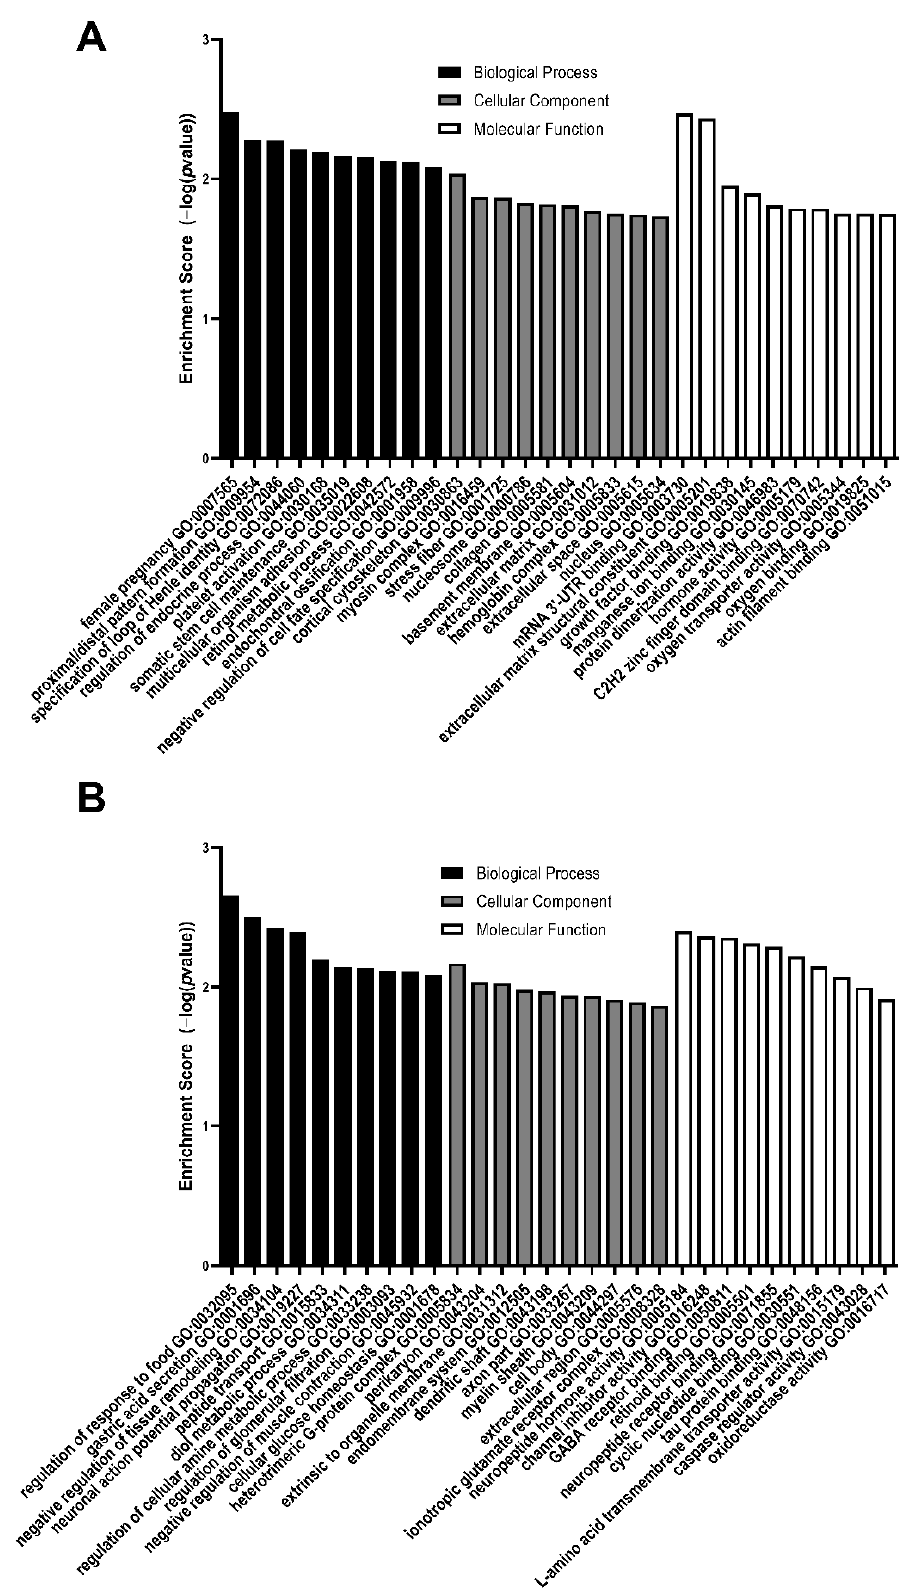
Figure 7. Enrichment scores of the top 10 GO biological processes, cellular components, and molecular function enriched from differentially expressed genes that are ( A ) upregulated or ( B ) downregulated in MMC spinal cords compared to vehicle at E17. All GO pathways were >1.5-fold and p < 0.05.